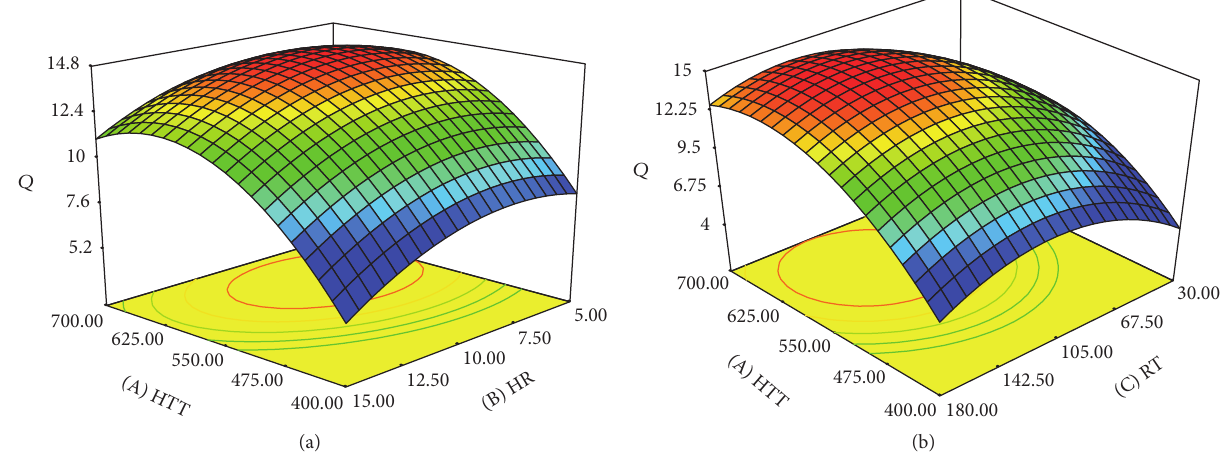
Figure 4: (a) Surface plot of adsorption capacity of biochar ( 𝑄 ) as a function of highest treatment temperature (HTT) and heating rate (HR) at fixed residence time of 105 minutes. (b) Surface plot of adsorption capacity of biochar ( 𝑄 ) as a Function of highest treatment temperature (HTT) and residence time (RT) at fixed heating rate of 10 ∘ C per